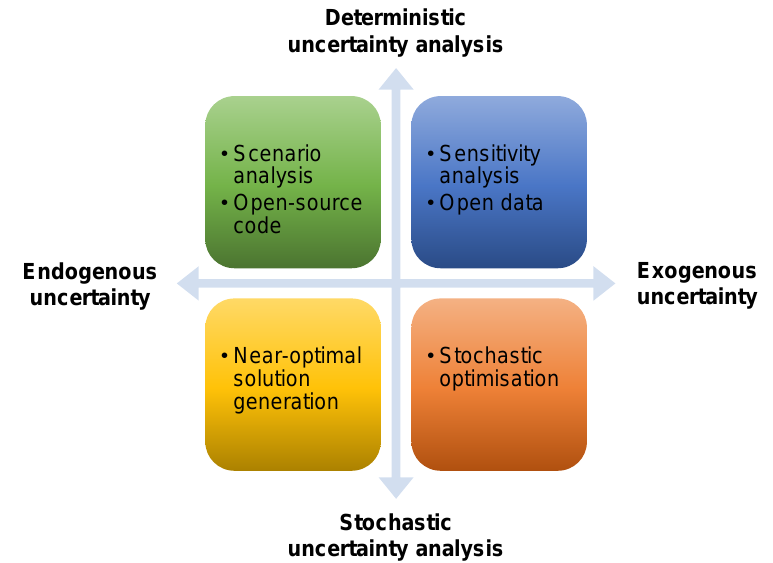
Figure 1. Uncertainty analysis matrix (UAM).